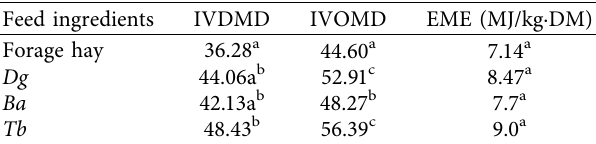
Table 5: In vitro digestibility (% DM) of leaf fodder from tested tree species.